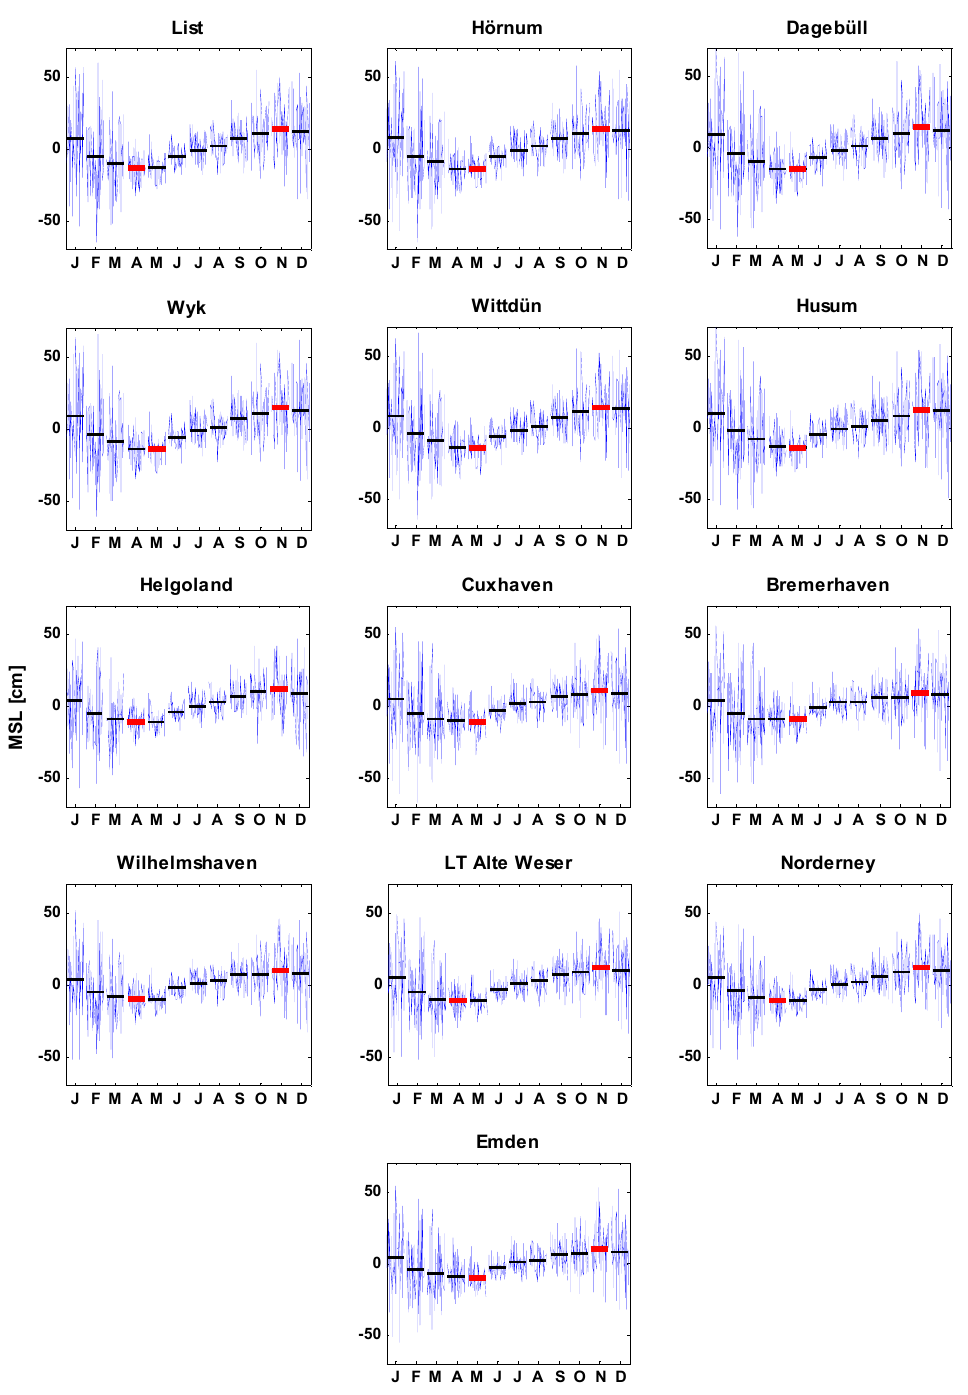
maximum and minimum values was found to be homogeneous between the different tide gauges. Figure 2. Plot of the annual MSL component for each gauge and the time period from 1951 to 2008. The blue line represents the monthly values for each year. The horizontal lines figure the mean value of the annual component for single months over the whole time span. The red lines figure the month where the minimum and maximum values of the annual component